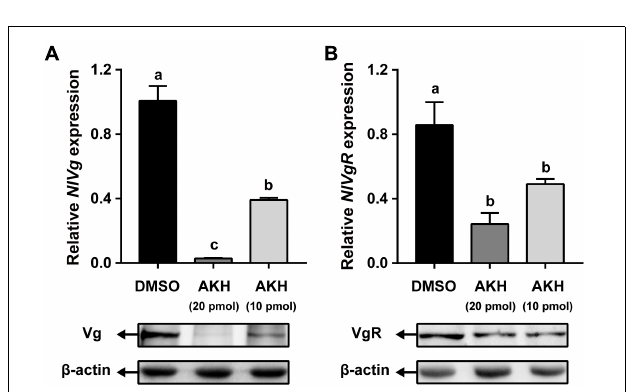
FIGURE 6 | Effects of AKH injection on the expression of Nl Vg and Nl VgR. Newly emerged females were injected daily with Nl AKH or the same volume of DMSO (control). Transcript levels and protein abundance of Nl Vg (A) in the fat body and Nl VgR (B) in the ovary were determined on the 3rd day. Each sample represents the means ± SE from three independent experiments. Differences between cDNA levels were determined by qPCR and analyzed using one-way ANOVA followed by Duncan’s multiple comparison. Different lowercase letters above the columns represent significant difference at P <